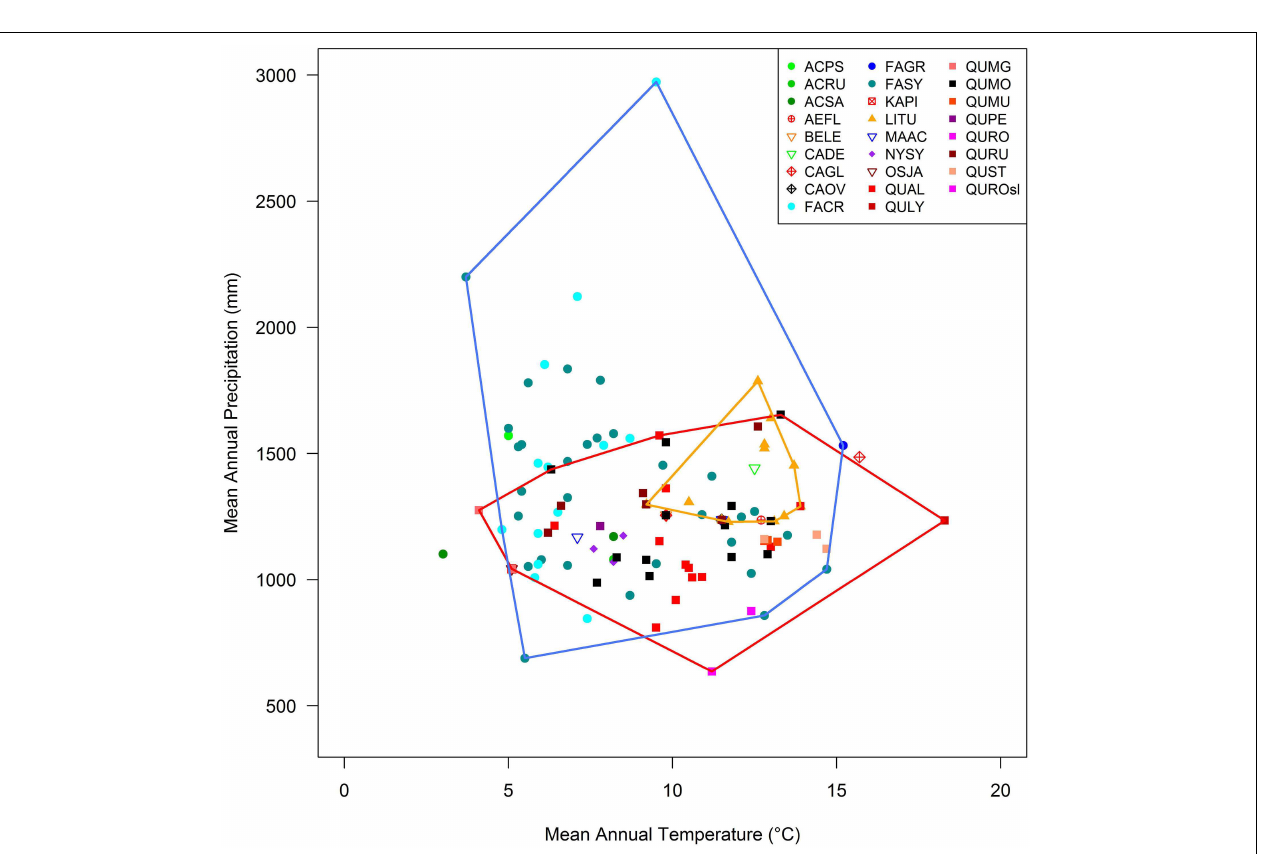
FIGURE 1 | Precipitation–temperature space occupied by the temperate deciduous forests analyzed. Symbols-colors refer to different genus-species. Convex hulls for Quercus , Fagus, and Liriodendron are drawn in red, blue and orange, respectively. Acronyms in Table 1 .